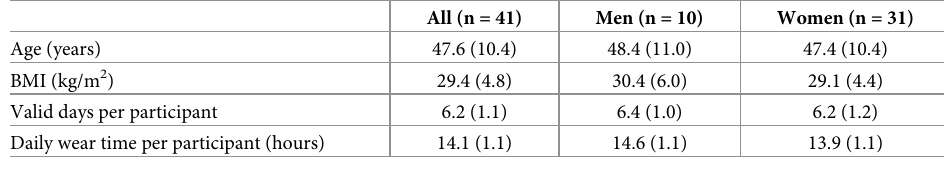
Table 1. Participant